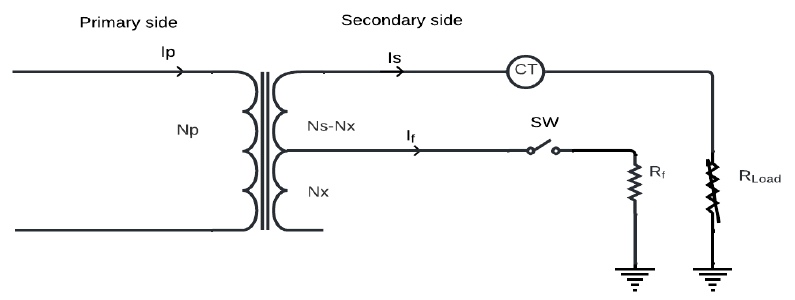
Figure 4. Turn–ground fault representation.